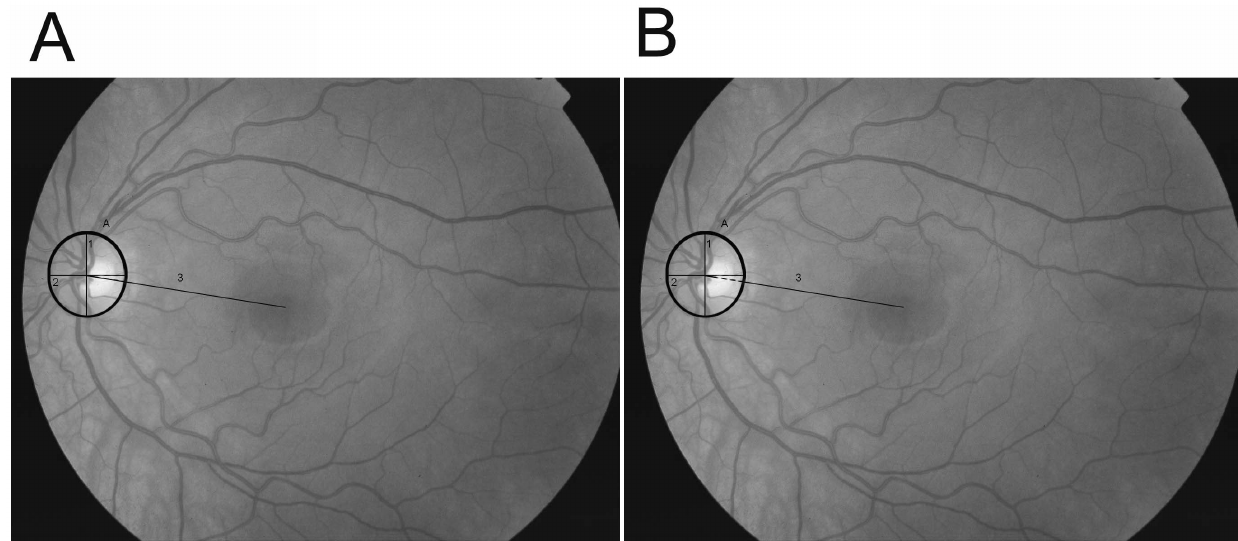
Figure 1. A. Nerve-head to fovea distance measured from the center (A) and B. from the rim (B) of the nerve-head.